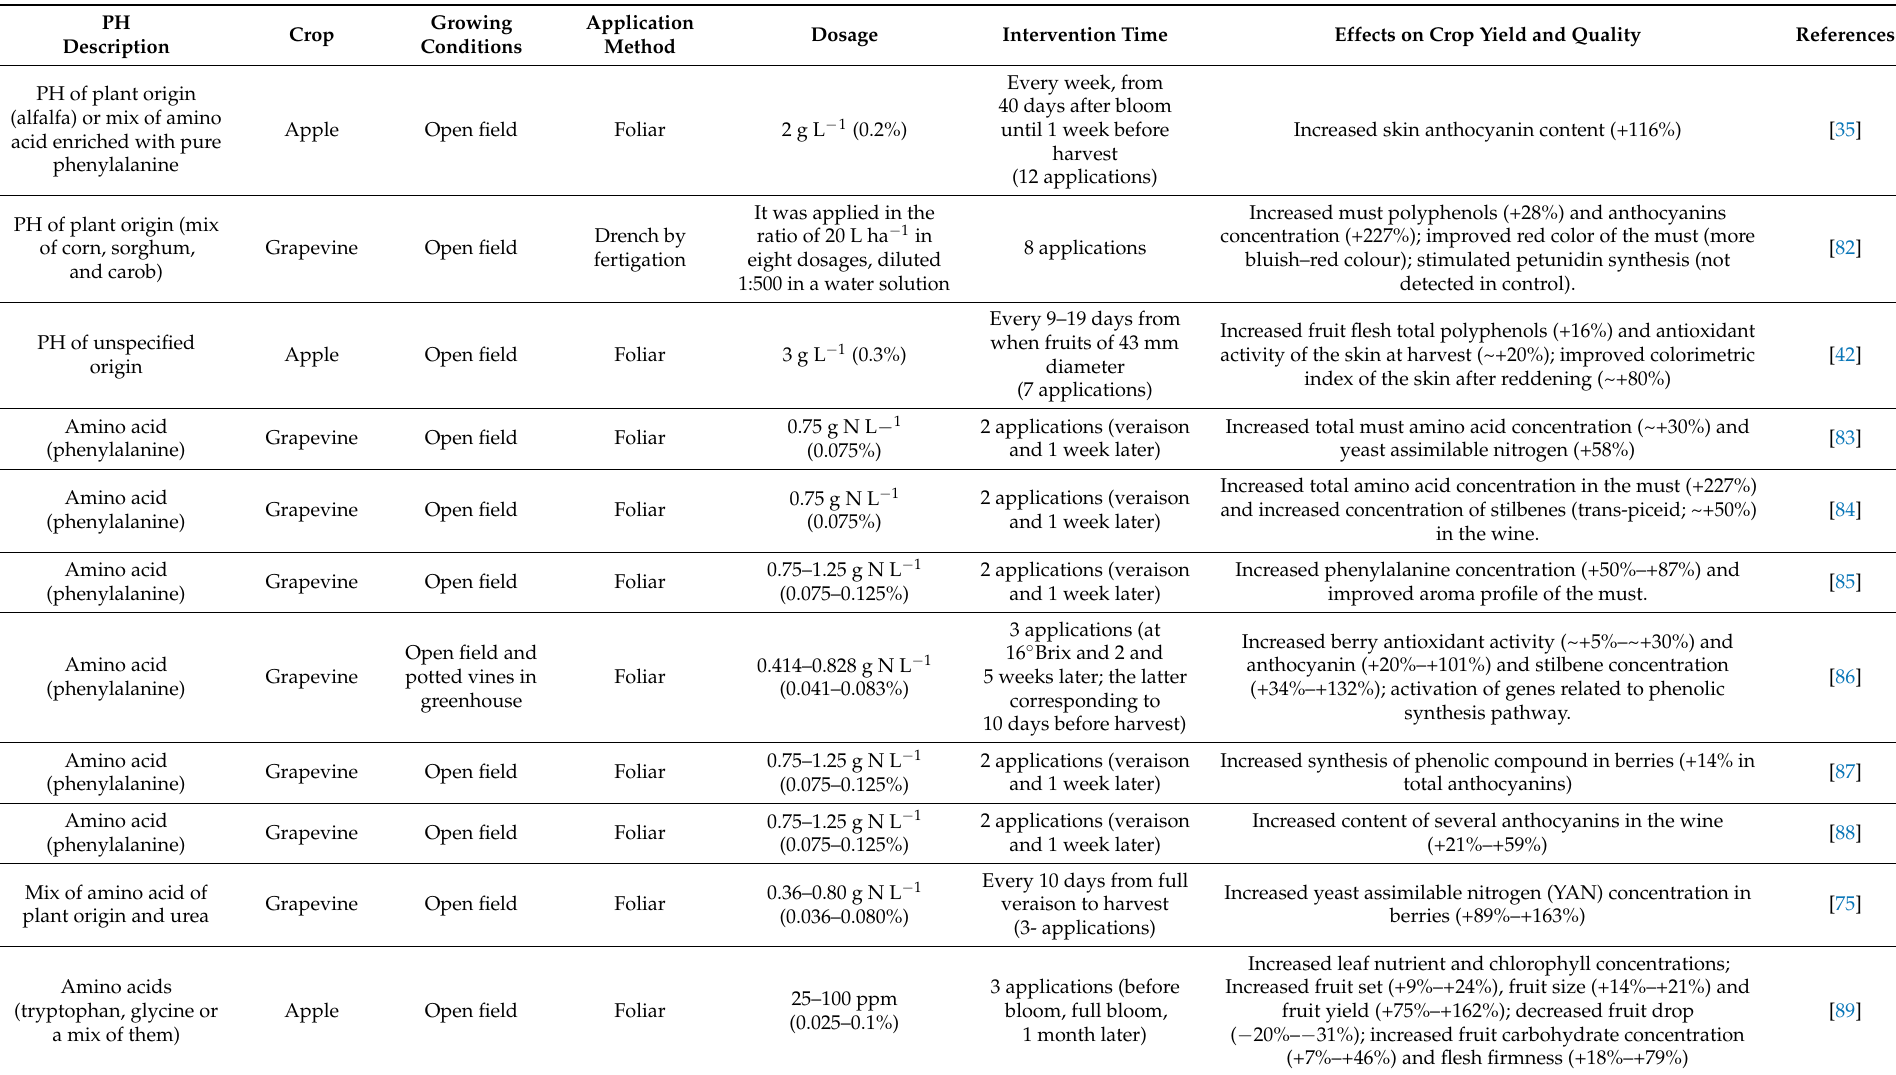
Table 8. Protein hydrolysate application methods to increase yield and product